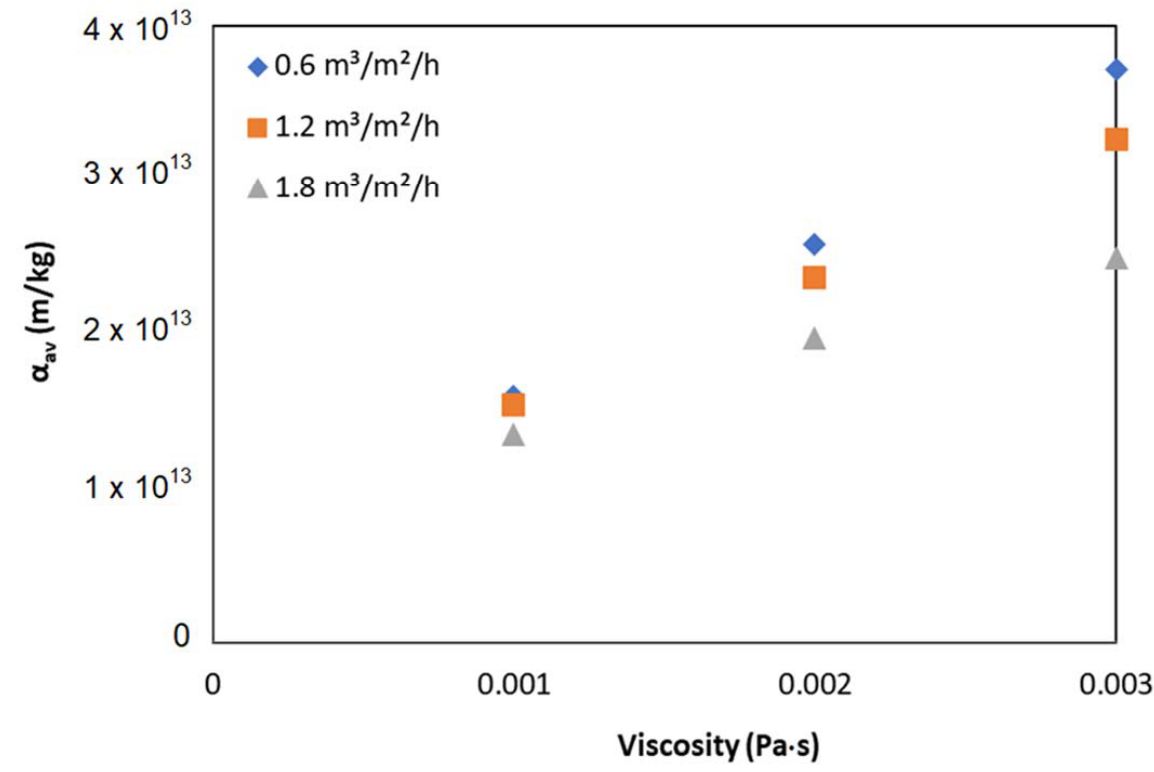
Figure 6. Effect of viscosity on specific filtration resistance.